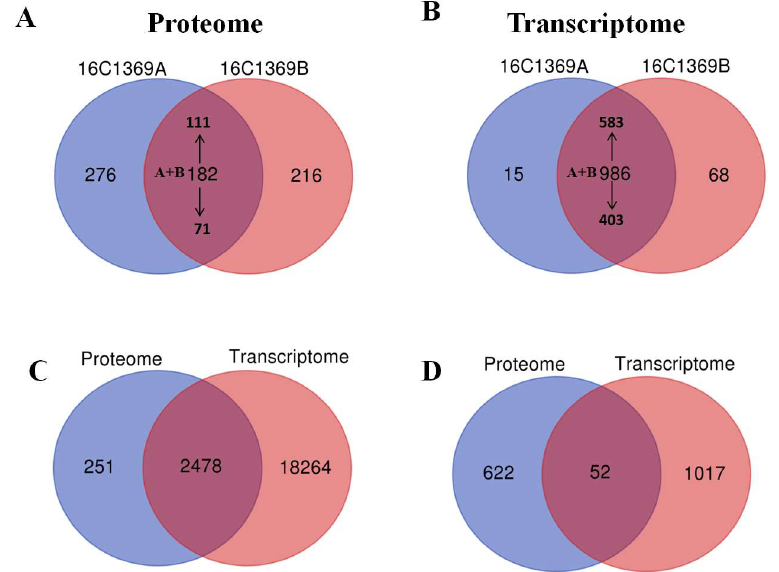
Figure 1. Pollen morphological features in anthers from the sterile line 16C1369A and fertile line 16C1369B. ( A – C , G ) Transverse sections of 16C1369B anthers; normal tapetum and mature anthers developed in the fertile line. ( D – F , H ) Transverse sections of sterile anthers; abnormal tapetum was formed, and pollen was not produced. ( A , D ) Pollen mother cell stage; ( B , E ) tetrad stage; ( C , F ) uninucleate stage; ( G , H ) mature stage. Td: tetrad; T: tapetum; MMC: microspore mother cell; dTd, death tetrad; MNM: mononuclear microspore; dTM: death tapetum and microspore; PG: pollen grain. Scale bars = 50 μm.